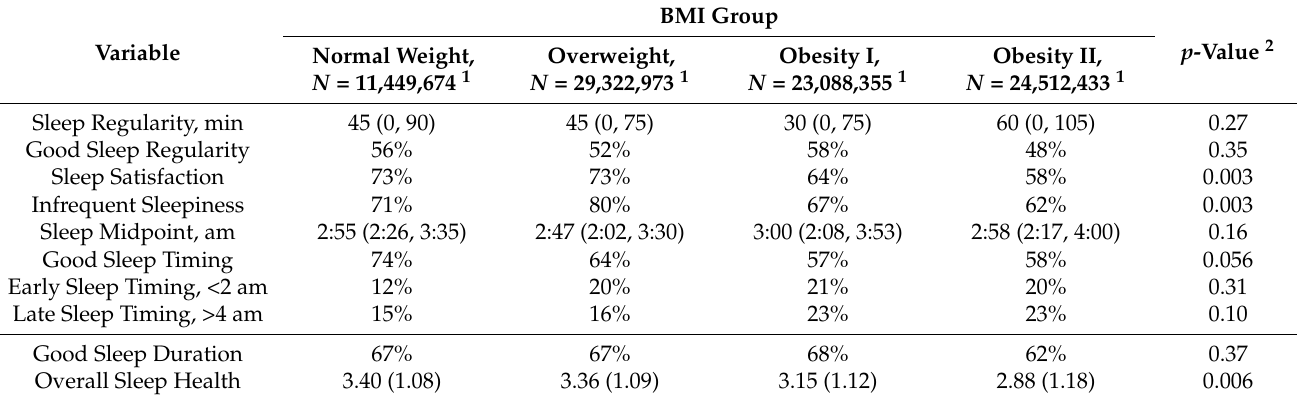
Table 4. Sleep characteristics in participants who attempted weight loss by BMI